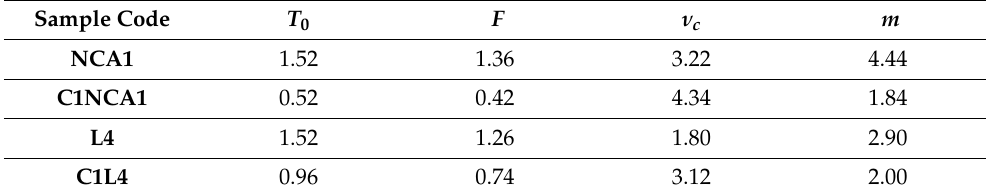
Table 1. The specific microscopic characteristics of the drug delivery systems. Sample Code